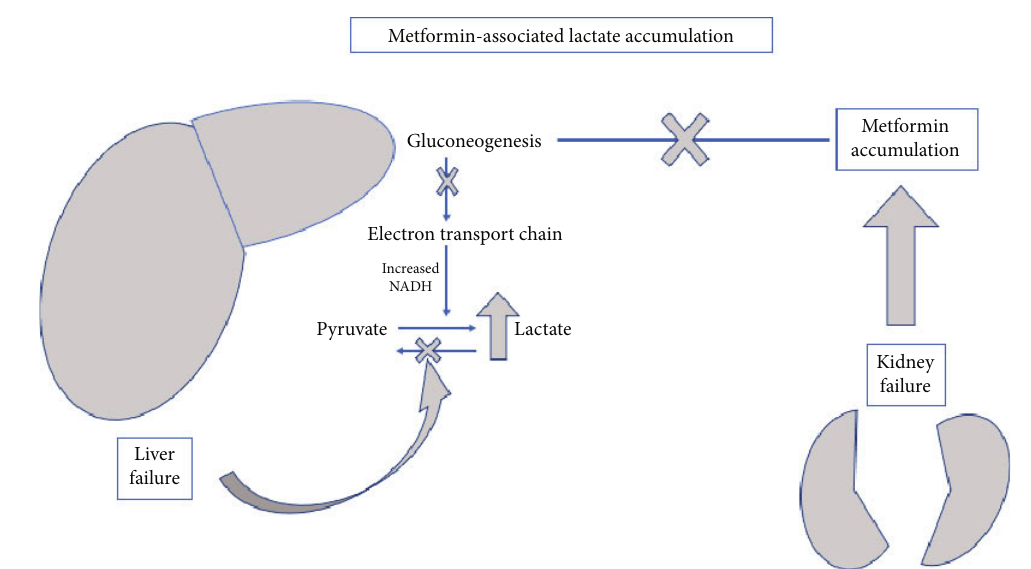
Figure 2: Metformin and lactic acidosis in liver or kidney